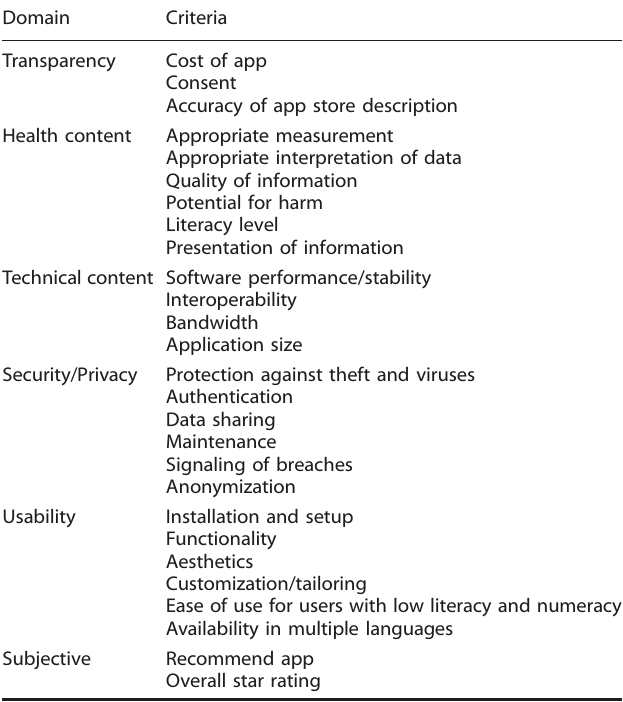
Table 1. Mobile health app rating domains and